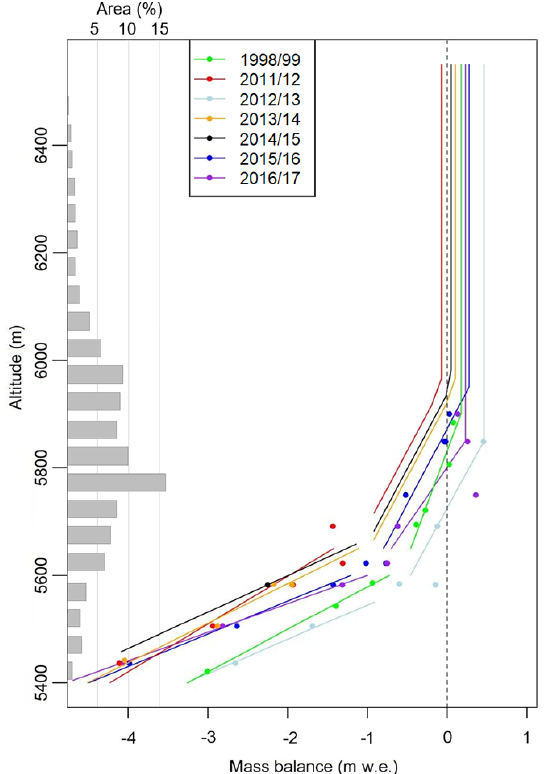
Figure 3. Point mass balance, gradients and hypsography of Rikha Samba Glacier for the mass-balance years 1998/1999 and for 2011/2012 to 2016/2017.